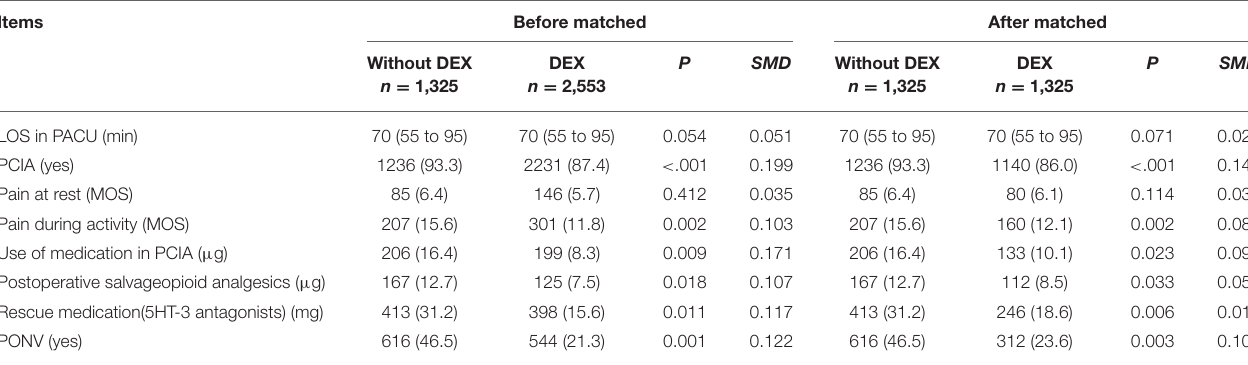
TABLE 3 | Patients data within 24h after operation. Items